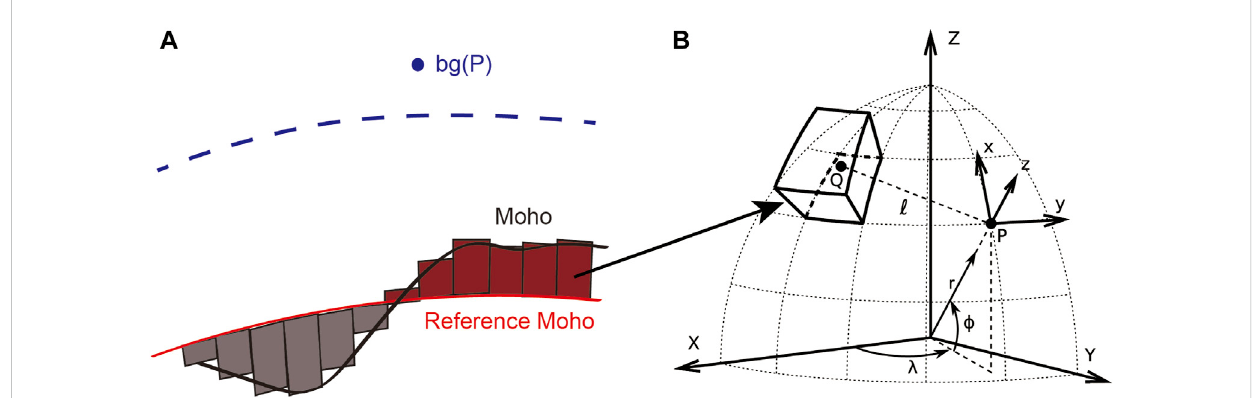
FIGURE 5 The calculation of theoretical gravity anomaly. (A) The discretization of the anomalous Moho (The grey block represents anegative density; The red block represents a positive density; The black line represents Moho; The red line represents the reference Moho); (B) The geocentric coordinate system [The P is the observation point and the Q is the integration point (Uieda et al.,